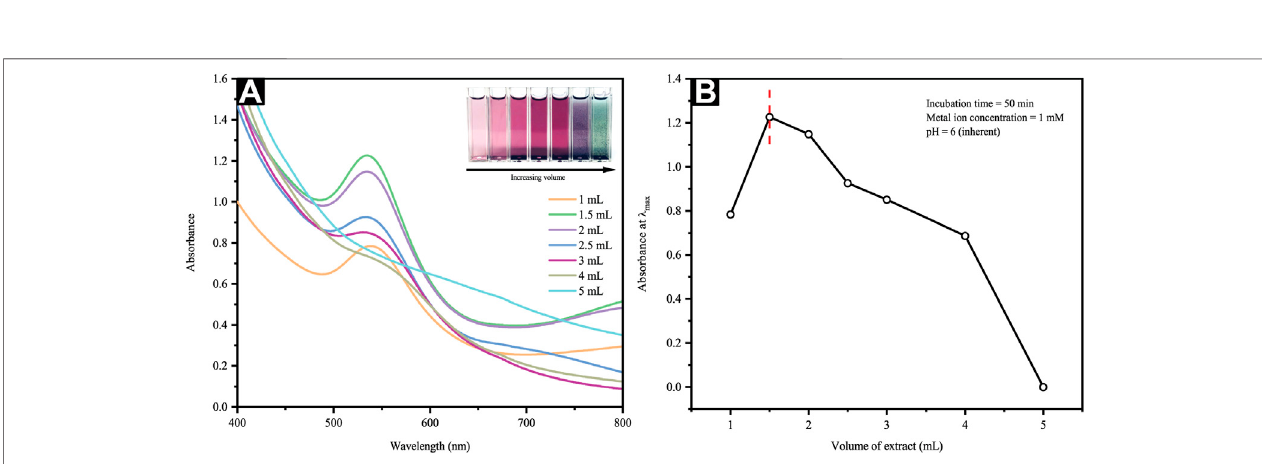
FIGURE 3 | (A) UV-Vis spectra and optical images of reaction mixtures at different extract volumes and (B) a plot of maximum absorbance versus extract volume.